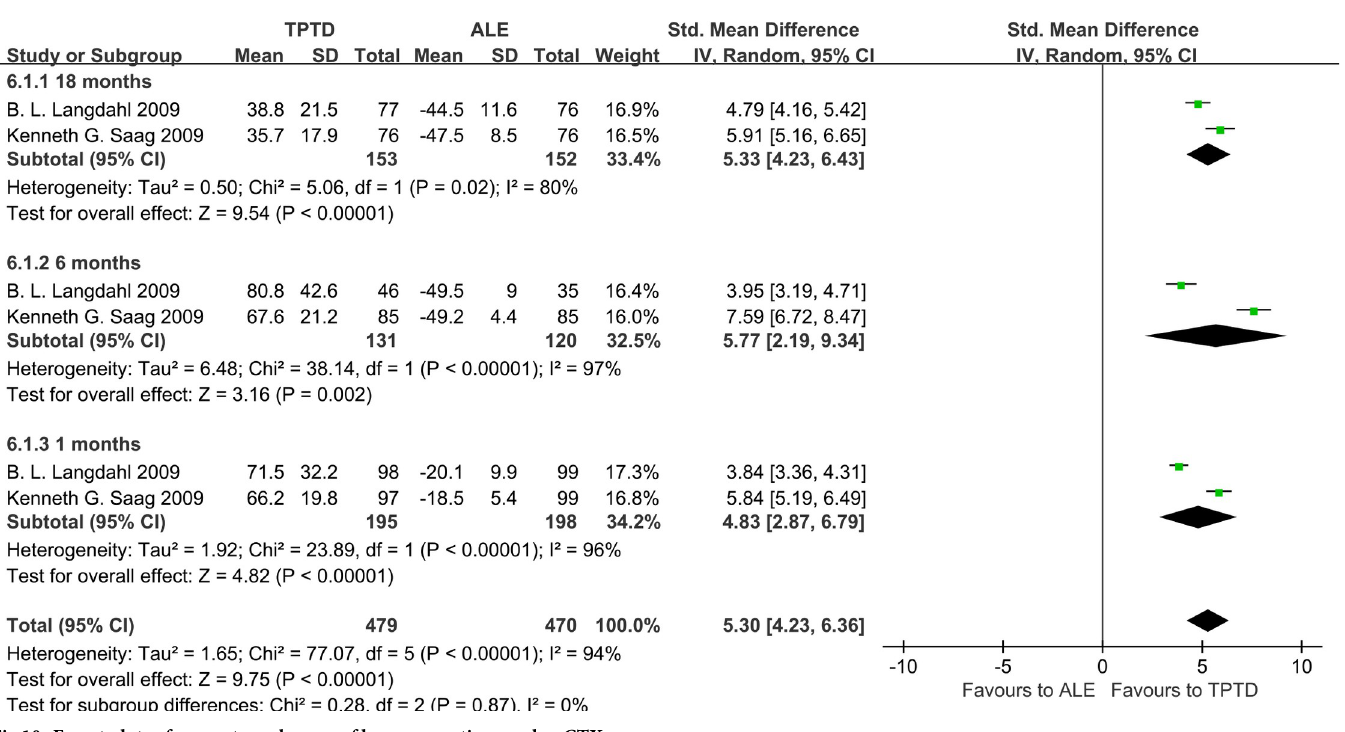
Fig 10. Forest plots of percentage changes of bone resorption marker CTX.